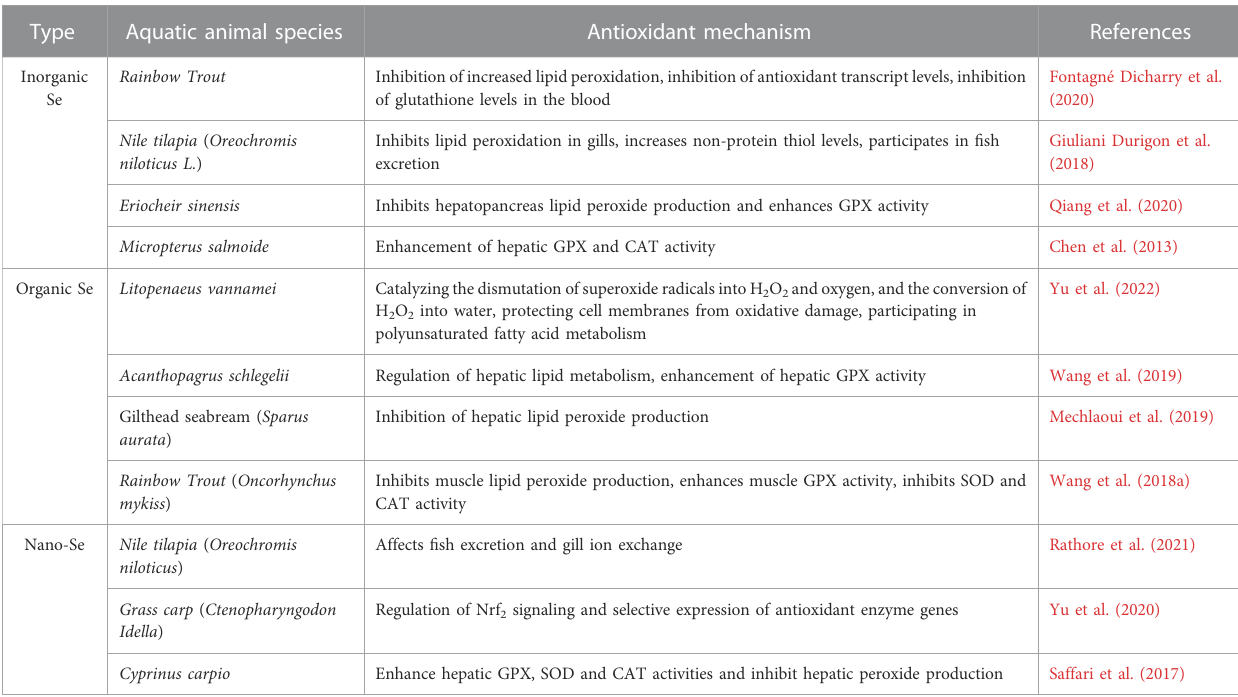
TABLE 2 Effects of different forms of Se on the antioxidant system of aquatic